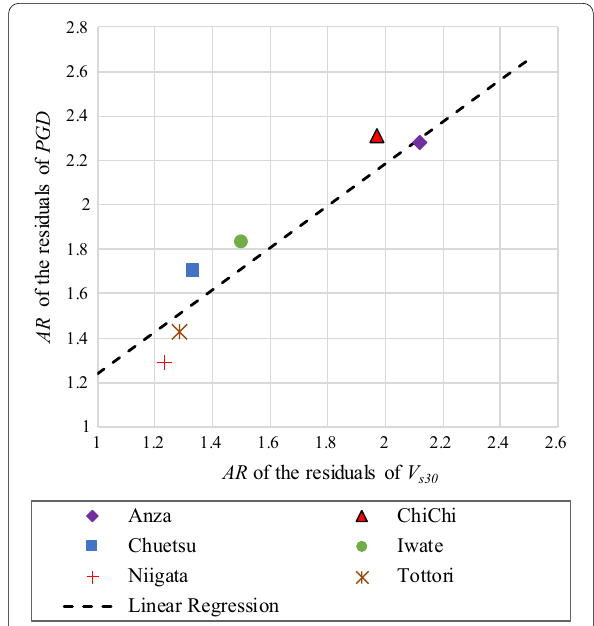
Fig. 11 AR of the residuals of the PGD versus AR of the normalized values of the V s30 for different